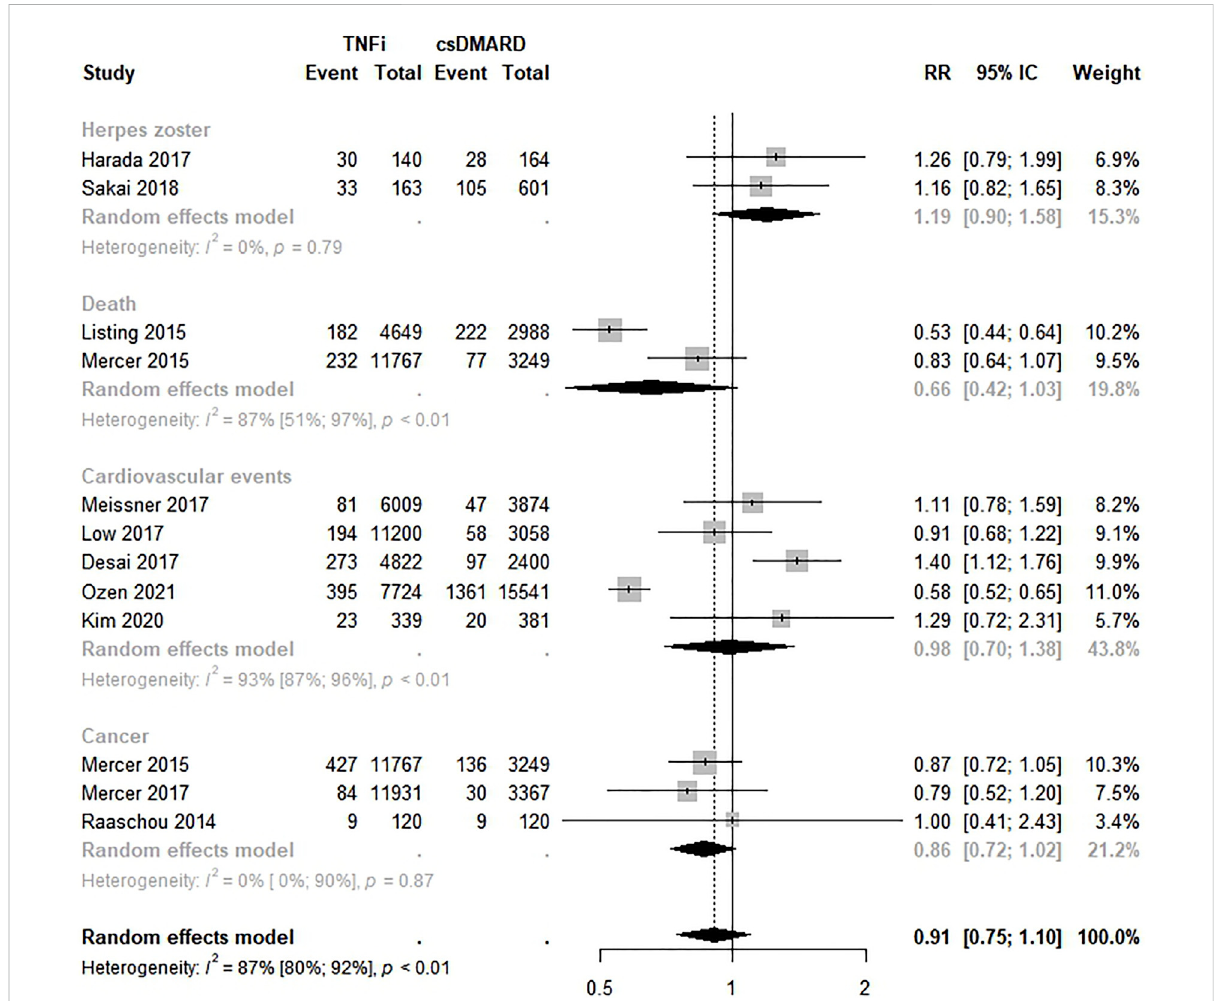
FIGURE 3 ComparativesafetyofTNFinhibitionsandconventionaldisease-modifyinganti-rheumaticdrugs.TNFi:TNFinhibitions;cDMARD:conventional disease-modifying anti-rheumatic